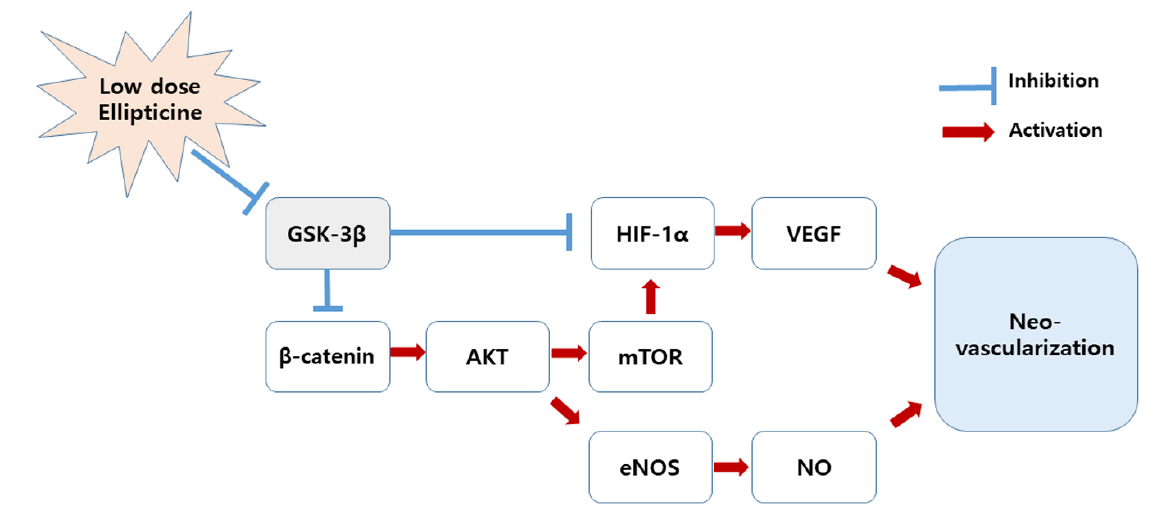
Figure 7. A possible pro-angiogenic mechanism for a low concentration of ellipticine. Low-dose ellipticine inhibits GSK-3β, thus upregulating β-catenin and HIF-1α. This ultimately promotes blood vessel regeneration. AKT, serine/threonine- specific protein kinase; eNOS, e ndothelial nitric oxide synthase; GSK-3β, glycogen synthase kinase-3β; HIF-1α, hypoxia- inducible factor-1α; mTOR, mechanistic target of rapamycin ; NO, nitric oxide; VEGF, vascular endothelial growth factor.